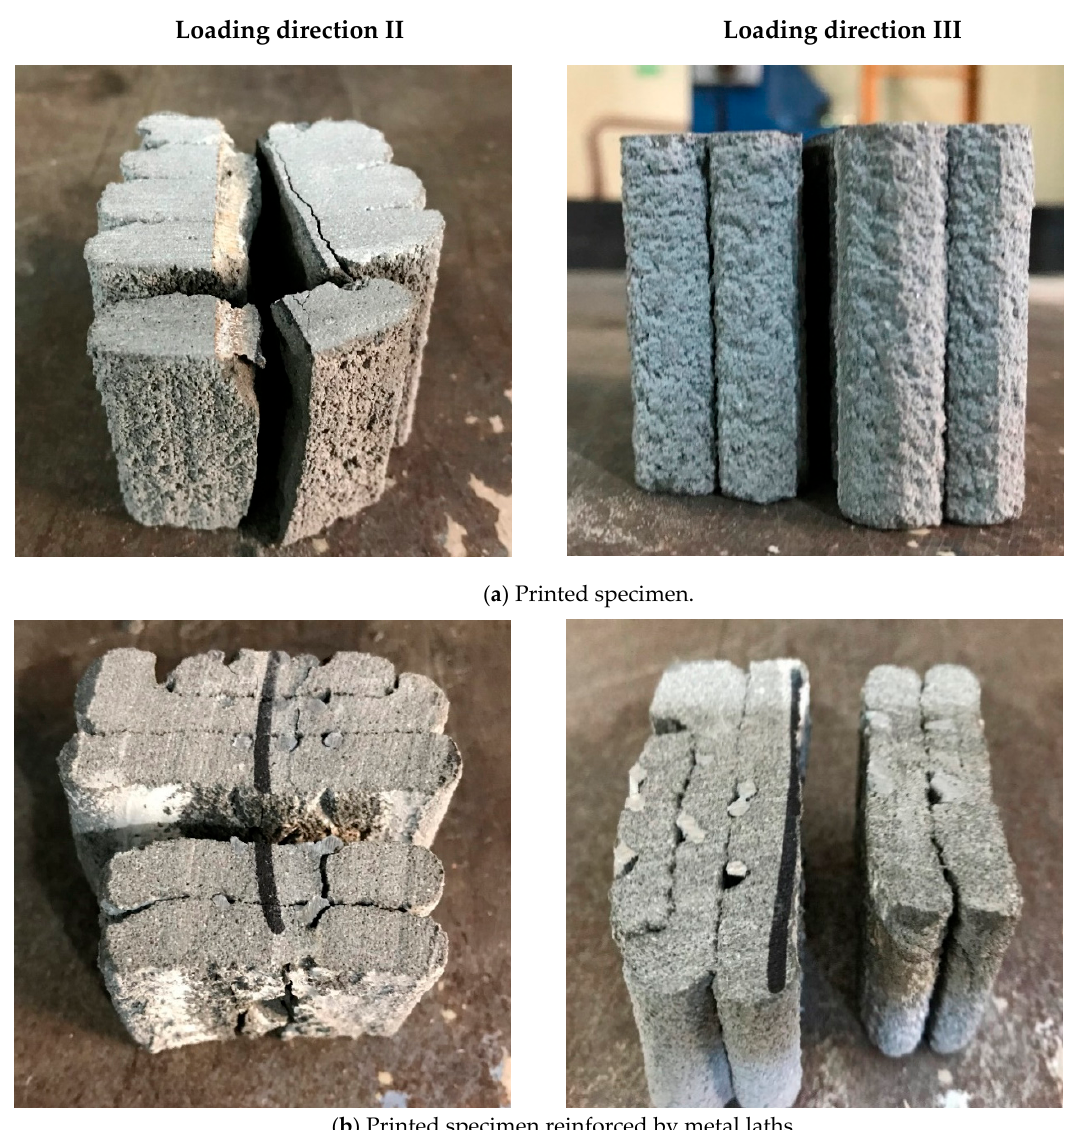
Figure 11. Splitting tensile failure of a printed specimen with and without metal lath in loading directions II and III. directions II and